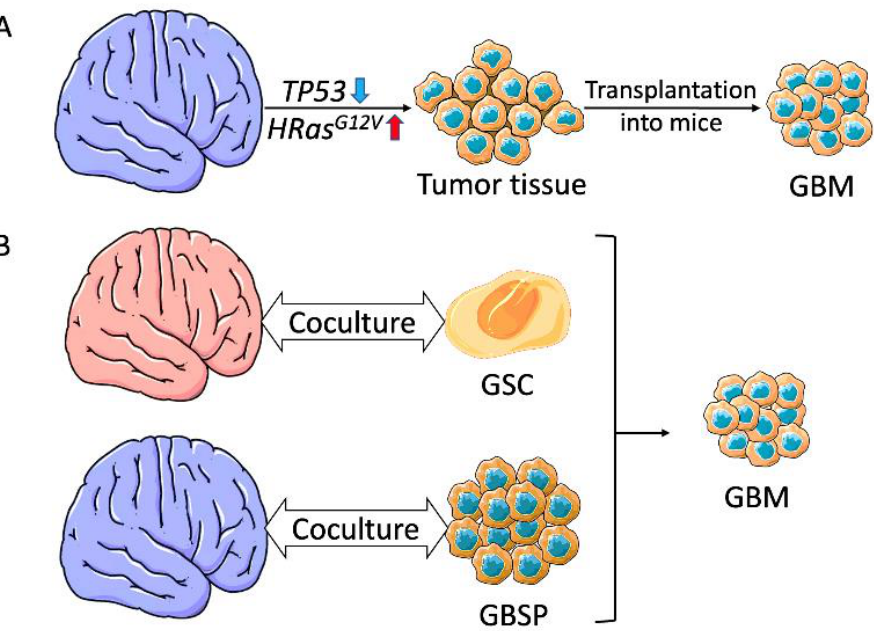
Figure 3. Modeling glioblastoma by genome editing and coculture. ( A ) Glioblastoma tumorigenesis by genome editing method. Cells from a brain organoid were edited by disruption of TP53 and activating HRas G12V . These cells then fragmented the brain organoid into tumor tissue. Glioblastoma-like tumors were obtained after transplanting the tumor tissue into mice. ( B ) Glioblastoma tumorigenesis by coculture. Coculturing iPSC-derived brain organoids with patient-derived GSCs or mature brain organoids with glioblastoma spheroids induces glioblastoma generation. GBM, glioblastoma; GSC, glioma stem cell; GBSP, glioblastoma